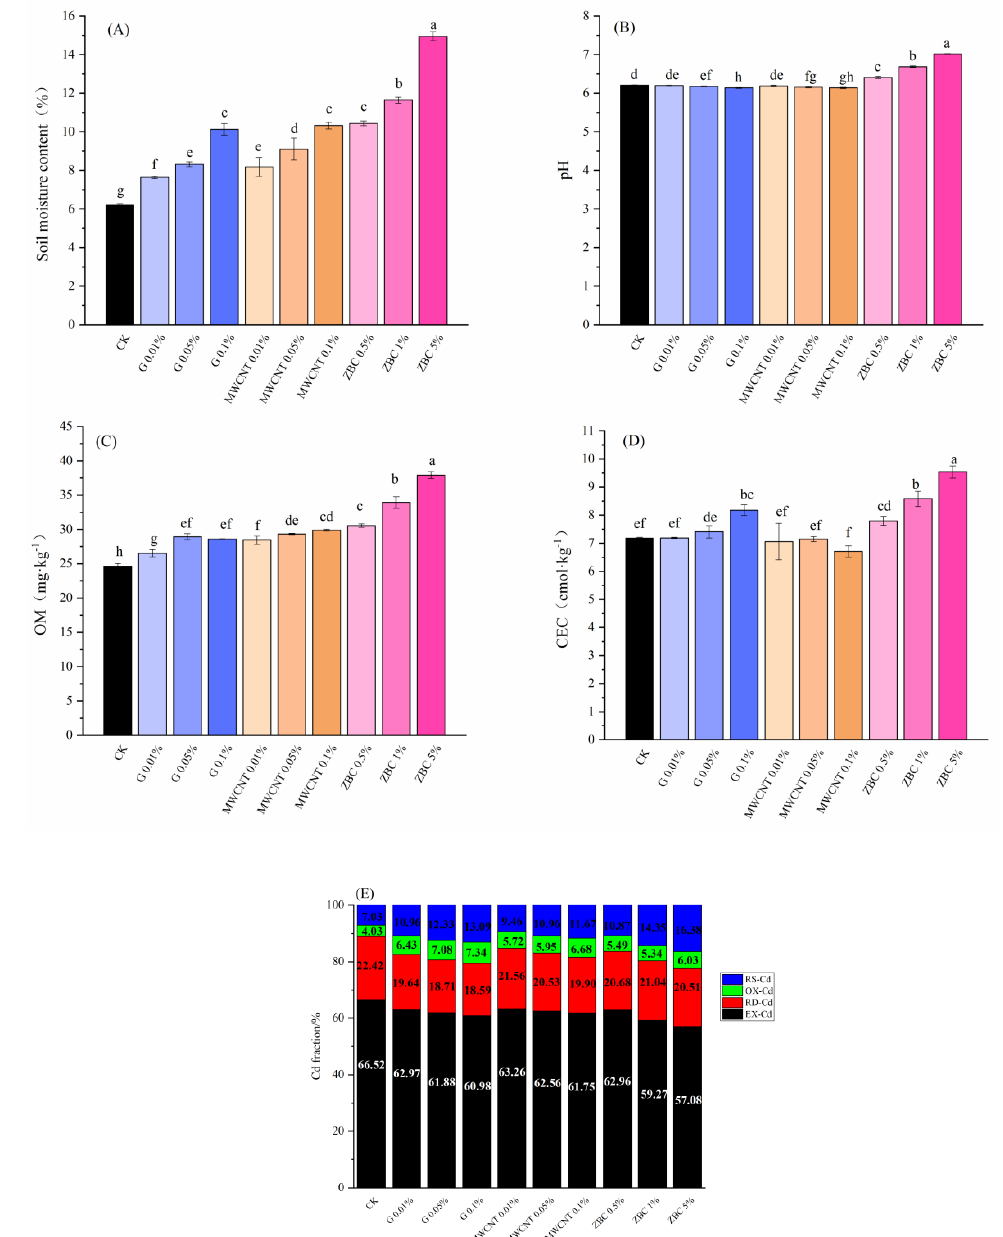
Figure 2. Effects of carbonaceous amendments on ( A ) moisture content, ( B ) pH, ( C ) OM (organic matter), ( D ) CEC (cation exchange capacity), and ( E ) Cd fractionation in the soils (n = 3). Different lowercase letters in the same column indicate significant differences between the treatments ( p < 0.05), and the same applies hereafter.